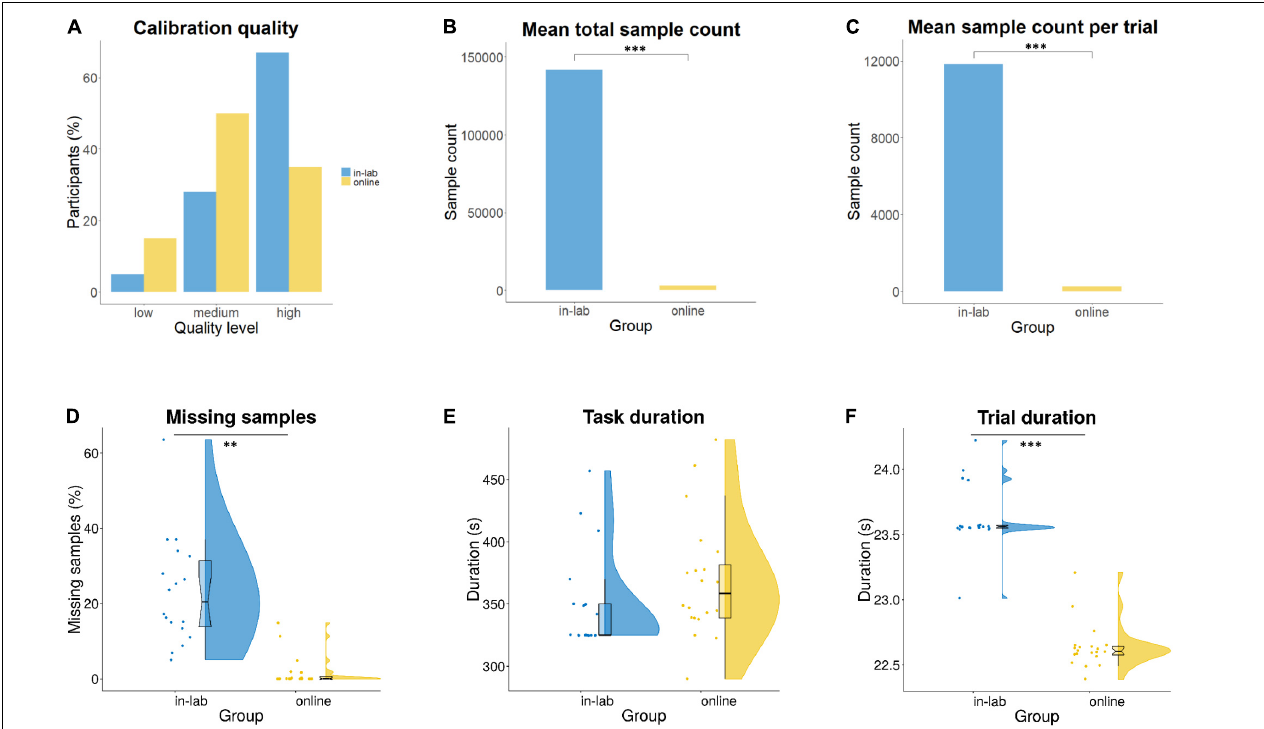
FIGURE 6 | Comparison of eye-tracking data quality in-lab and online, based on (A) calibration quality; (B) mean total sample count ( ∗∗∗ p < 0 . 001); (C) mean trial level sample count ( ∗∗∗ p < 0 . 001); (D) missing samples (gaze points with no x and y coordinates recorded) relative to the total number of recorded samples ( ∗∗ p < 0 . 01); (E) task duration; and (F) trial duration ( ∗∗∗ p < 0 . 001).